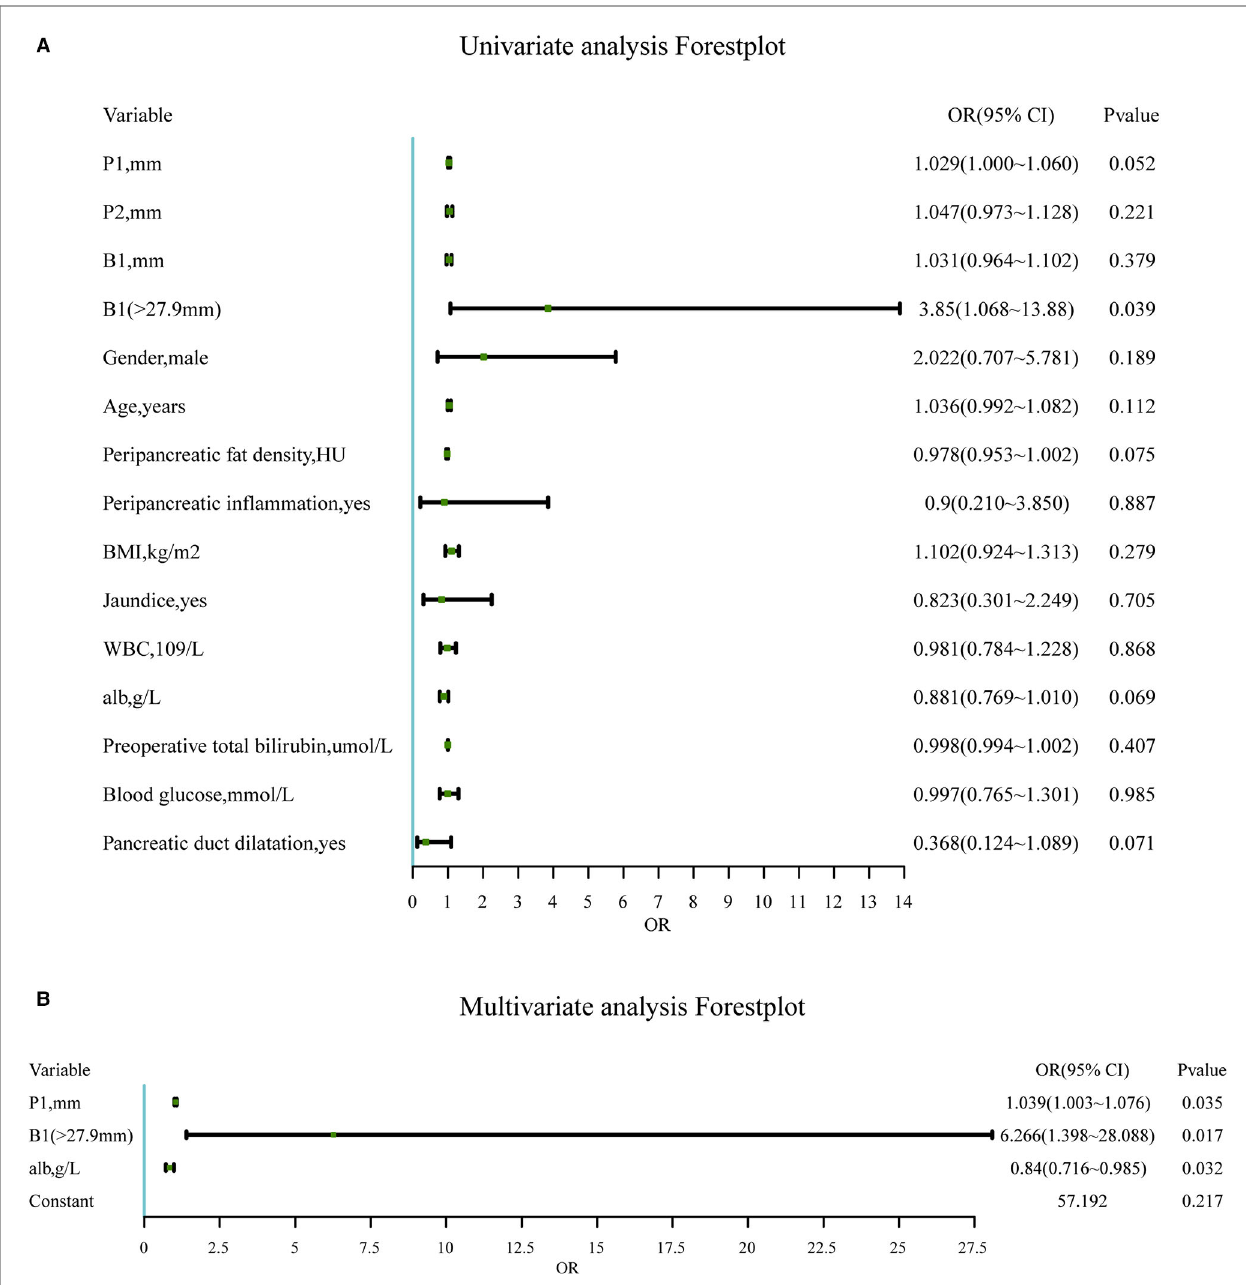
FIGURE 4 | ( A ). Univariate analysis of candidate predictors associated with the dif fi culty of RPD surgery. *Statistically signi fi cant (univariate binary logistic regression). ( B ). Signi fi cantly independent multivariable predictors of the dif fi culty of RPD surgery. The multivariable logistic regression model is adjusted for the site. Abbreviations: P1, mesenteric tissue thickness; P2, length of the uncinate process; B1, thickness of the abdominal wall; BMI, body mass index; WBC, white blood